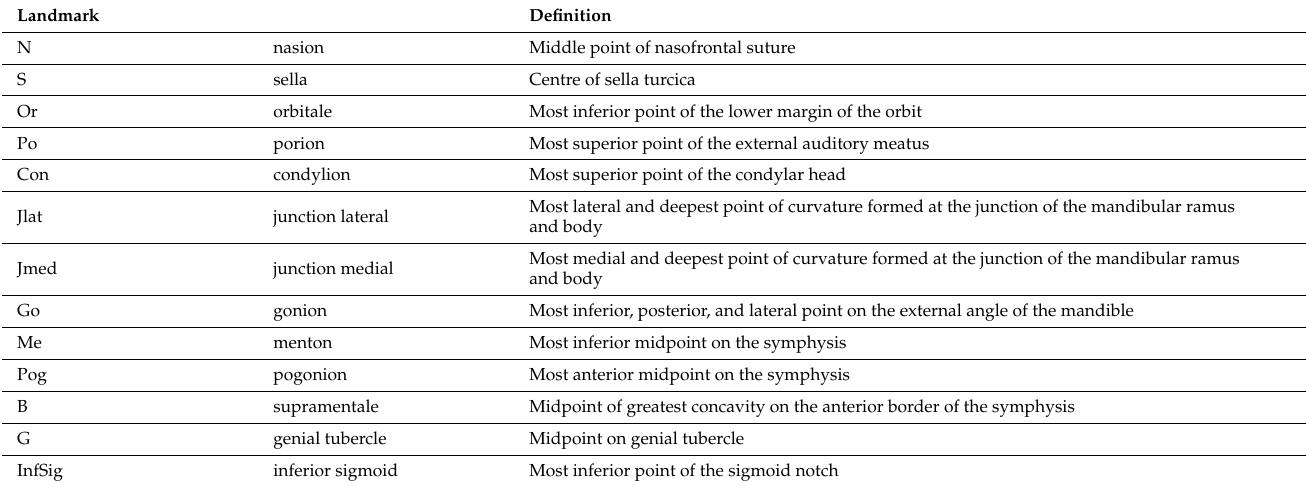
Table 1. Three-dimensional